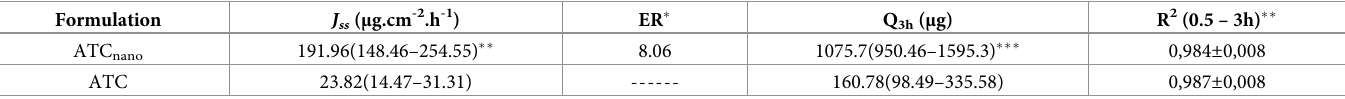
Table 3. Calculated steady-state fluxes ( J ss ) and cumulative amounts of ATC permeated after 3 h (Q 3h ), for ATC permeation across fresh swine esophageal epithe- lium from formulations applied under infinite dose conditions. Formulation